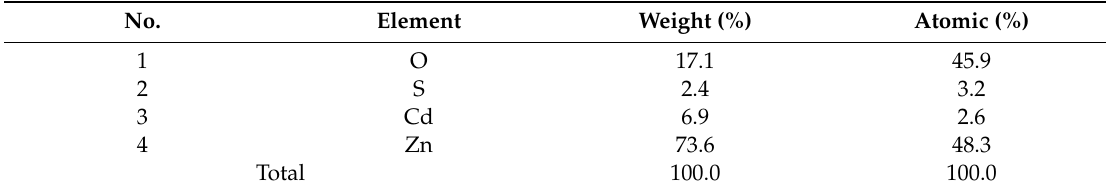
Table 1. Elemental composition of CdS nanoparticle-doped ZnO nanofibers by EDX. No. Element Weight